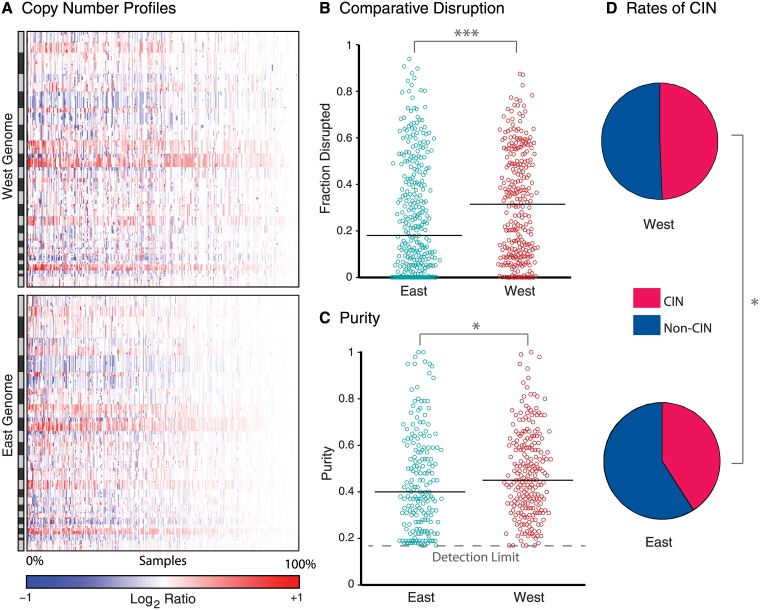
Genomic disruption between Eastern and Western samples.(A) Copy number profiles of Western (top) and Eastern (bottom) samples (x-axis; decreasing genomic disruption towards the left) across the genome (y-axis). Amplifications are in red and deletions in blue. (B) Fraction of the genome disrupted and (C) purity estimates of samples (circles) in each cohort. Solid lines represent median values; the dashed line represents the minimum purity detection limit. (D) Rates of CIN in each cohorts. Single and triple asterisks indicate p≤0.05 and p≤0.001, respectively.